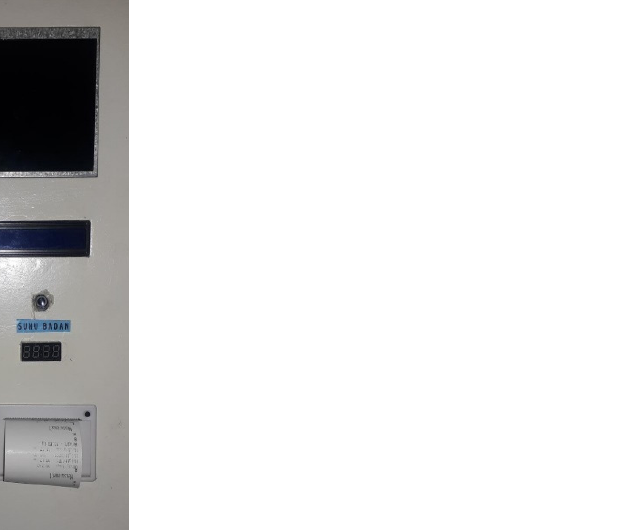
Figure 2. Control box of the anthropometric system and its components including push button. LCD 16 × 2, LCD 7 inch, seven segment display, temperature sensor, and thermal printer.